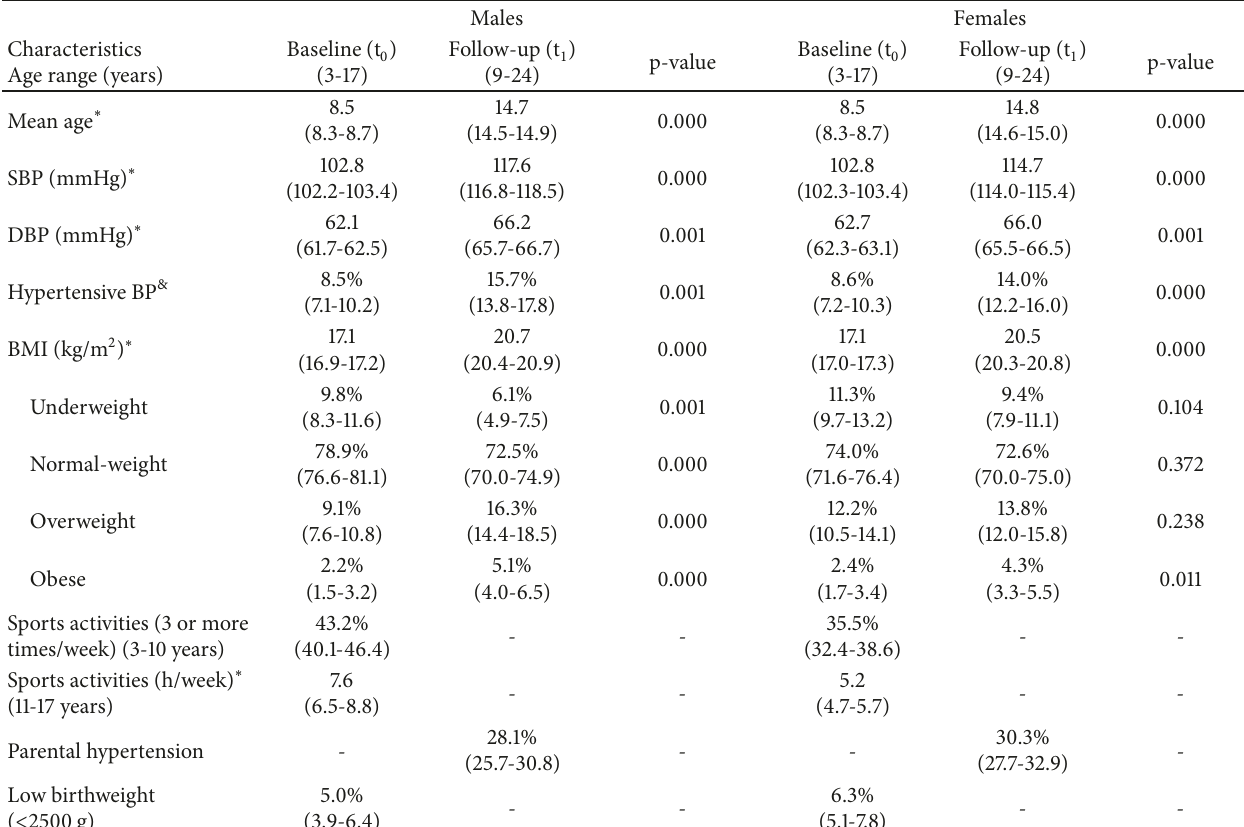
Table 1: Characteristics of the 2542 study participants (1269 males and 1273 females) at baseline (2003-2006) and at follow-up (2009-2012).